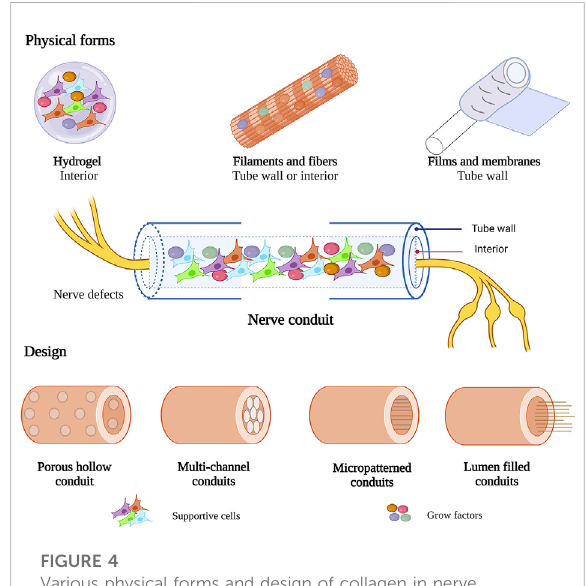
FIGURE 4 Various physical forms and design of collagen in nerve conduit. This fi gure was created with